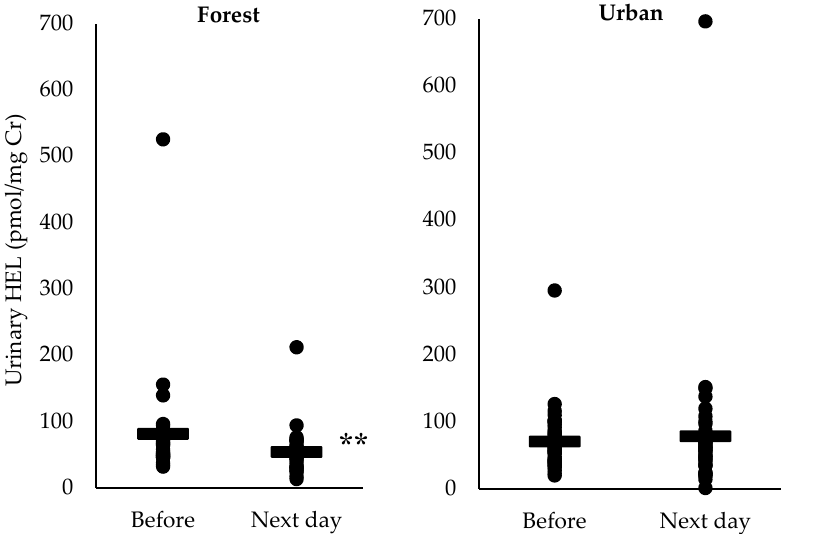
Figure 3. Urinary hexanoyl-lysine (HEL) concentration pre- and post-forest walk or urban walk. “ ― ” denotes mean; ** p < 0.05: pre-forest walk vs. post-forest walk analyzed by Mann–Whitney U